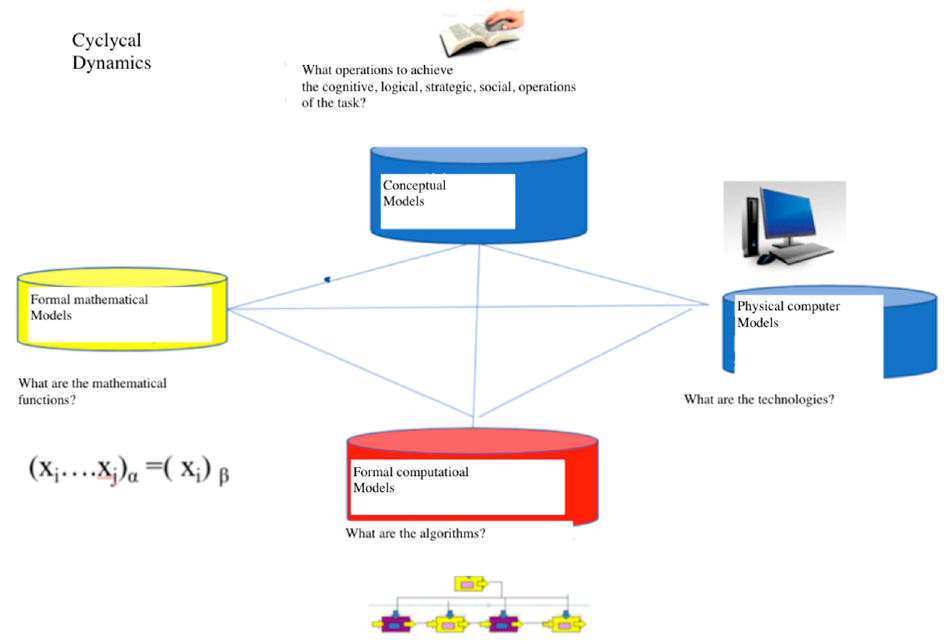
Figure 1. Model dynamics (Meunier 2019a).